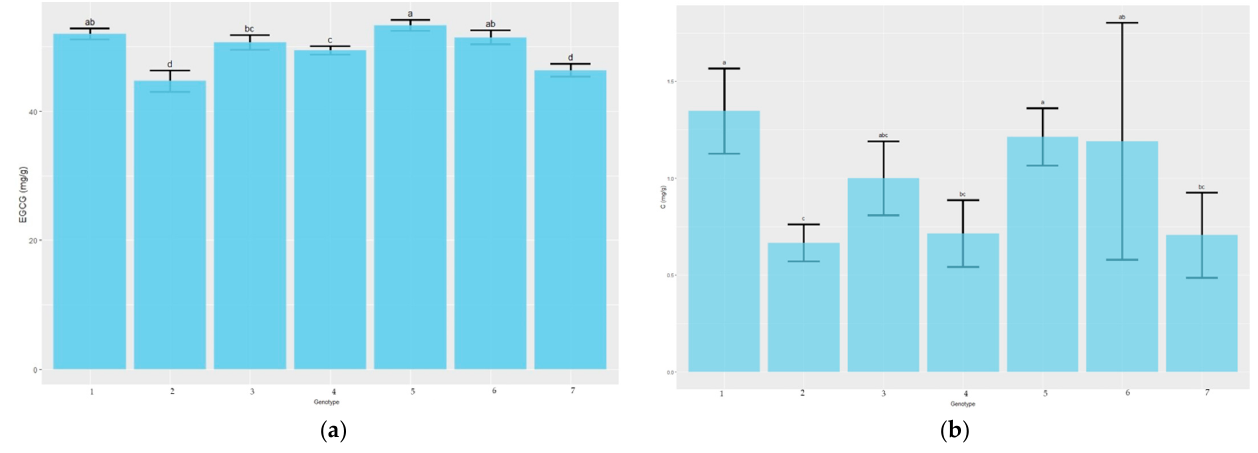
Figure 2. The content of EGCG and C. ( a ) EGCG content; ( b ). C content. 1: ‘Kiara-8’ × ‘Sukoi’, 2: ‘Tambi-1’ × ‘Kiara-8’, 3: ‘Tambi-2’, 4: ‘Tambi-2’ × ‘Cinyiruan-143’, 5: ‘Tambi-2’ × ‘Suka Ati-40’, 6: ‘Tambi-2’ × ‘TRI-2025’, 7: ‘TRI-2025’. Data are presented as mean ± SD of three independent biological replicates. Uppercase letter (a, b, c, and d) indicates significant difference ( p < 0.05). In order to decode the genes involved in the differential phenotype in ‘TRI-2025 ′ , ‘Tambi-2 ′ , ‘Tambi-1 ′ × ‘Kiara-8 ′ , ‘Tambi-2 ′ × ‘Suka Ati-40 ′ , ‘Tambi-2 ′ × ‘Cinyiruan-143 ′ , ‘Tambi-2 ′ × ‘TRI-2025 ′ , and ‘Kiara-8 ′ × ‘Sukoi’, we de novo sequenced and assembled the transcriptome from leaf samples of the seven tea plants. The readings of clean reads of each sample remaining are presented in Supplementary Table S1. The GC content of the clean data was above 43%, and the quality score Q20 and Q30 percentage was above 97% and 93%, respectively (Supplementary Table S1). The longest transcripts of each cluster were selected as unigenes. The total number of transcripts obtained was 333,310, and the total number of unigenes was 121,530, which, in turn, could be broken down into different groups of length intervals (Supple- mentary Table S2). The length distribution of transcripts and unigenes is shown in Sup- plementary Table S3. A total of 384,480,750 transcripts with a mean length of 1154 bp and an N50 length of 1649 bp were obtained. A total of 124,031,600 unigenes with a mean length of 1021 bp and an N50 length of 1477 bp were obtained. 2.2. Gene Functional Annotation and Classification To achieve comprehensive gene functional annotation, seven databases were ap- plied, resulting in a total of 121,530 functionally annotated genes (Supplementary Table S4). Gene functional classification is shown in Figure 3a. The cellular process and meta- bolic process were the most enriched GO terms, cellular anatomical entity, intracellular, and protein-containing complexes were the most enriched cellular component GO terms, while binding and catalytic activities were clearly enriched as molecular functions (Fig- ure 3a). These results suggested that transcription factors (binding activity) and high enzymatic activity were involved in the biosynthesis of samples. The genes successfully annotated in KEGG could further be classified according to the KEGG pathway they were joined in. The metabolic pathways were mainly related to carbohydrate metabo- lism, amino acid metabolism, lipid metabolism, metabolism of cofactors and vitamins, biosynthesis of another secondary metabolism, nucleotide metabolism, and metabolism of terpenoids and polyketides (Figure 3b).